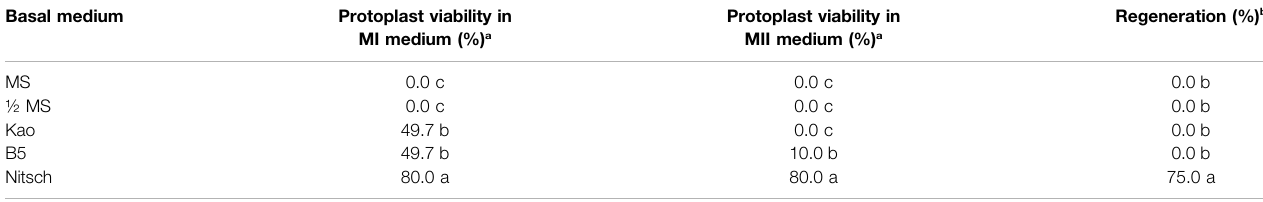
TABLE 1 | Effect of basal medium on protoplast viability of fi eld cress. Basal medium